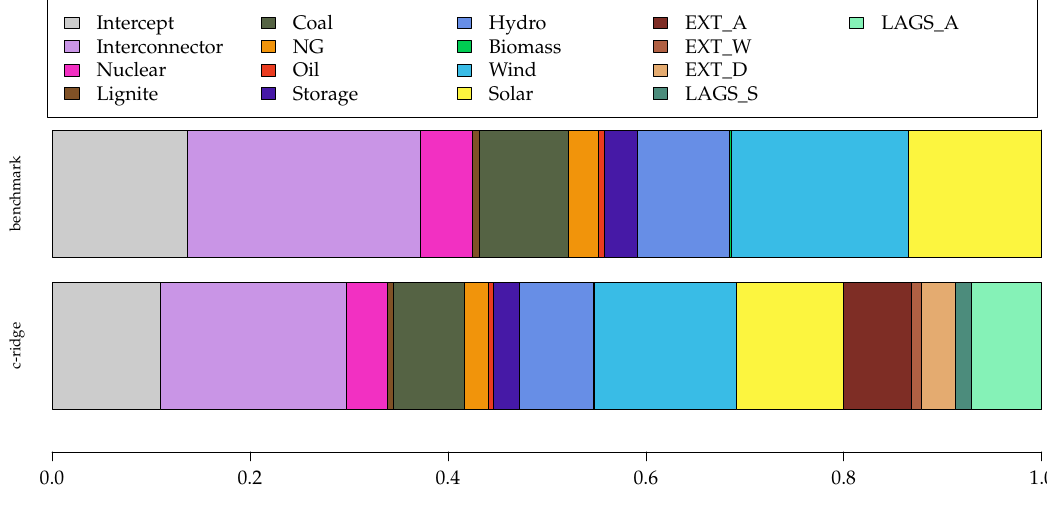
/ of Model c-ridge ∗ for 2years and benchm for (cid:98) β (cid:98) β i | | (cid:107) (cid:107) 1